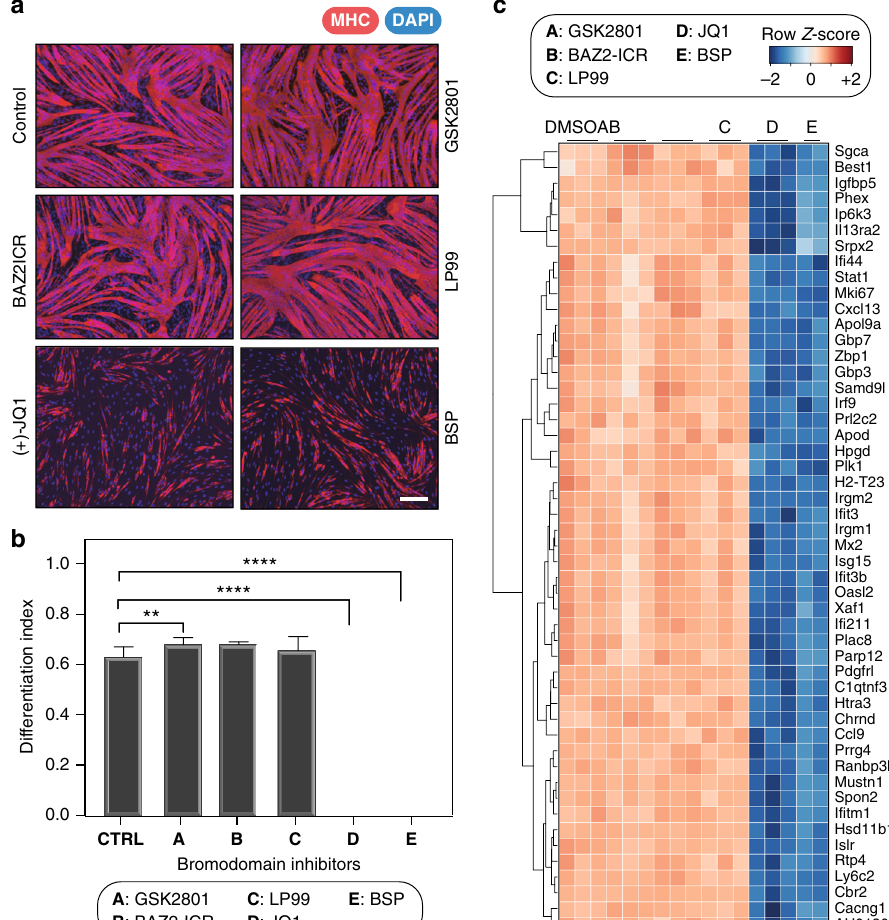
Fig. 4 In fl uence of bromodomain inhibition on C2C12 myoblast differentiation. a Fluorescent images of myotubes cultured in differentiation media (Dulbecco ’ s modi fi ed Eagle ’ s medium (DMEM) containing 2% horse serum, 10 µ gml − 1 insulin, and 10 µ gml − 1 transferrin) in the presence or absence of bromodomain chemical probes. Cells were allowed to differentiate for 48 h before they were processed for immuno fl uorescence staining with α -myosin heavy-chain antibody (Red). Nuclei are stained blue with 4 ′ ,6-diamidino-2-phenylindole (DAPI). Images were acquired at ×10 using Zeiss Axio Observer Z1 microscope. b Quantitation of differentiated cells after inhibitor treatment. Post immuno fl uorescence, differentiation index was calculated by dividing the number of nuclei in myosin heavy-chain-expressing myotubes by the total number of nuclei per fi eld. For JQ1 and BSP, the differentiation index declined signi fi cantly [**** p < 0.0001] while treatment with GSK2801 slightly improved the differentiation index [** p < 0.0053]. Treatment with BAZ2-ICR ( p = 0.1773) and LP99 ( p = 0.1959) did not have signi fi cant impact on the differentiation index. P-values were calculated using two-tailed t test and error bars represent standard deviation (s.d., n = 3). c Heatmap of the top 50 statistically signi fi cant genes that were differentially expressed (using the Benjamini-Hochberg adjusted p -value < 0.001) following 12 h treatment with speci fi c BRD